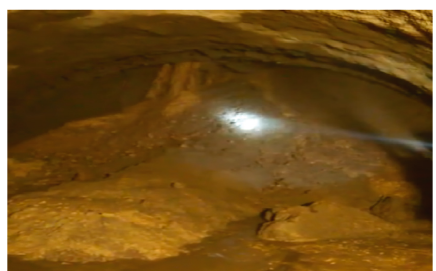
Figure 6: Site of tunnel collapse